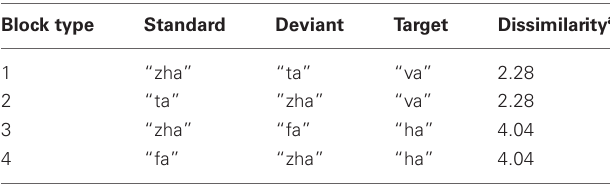
Table 1 | Syllables included in each of four block